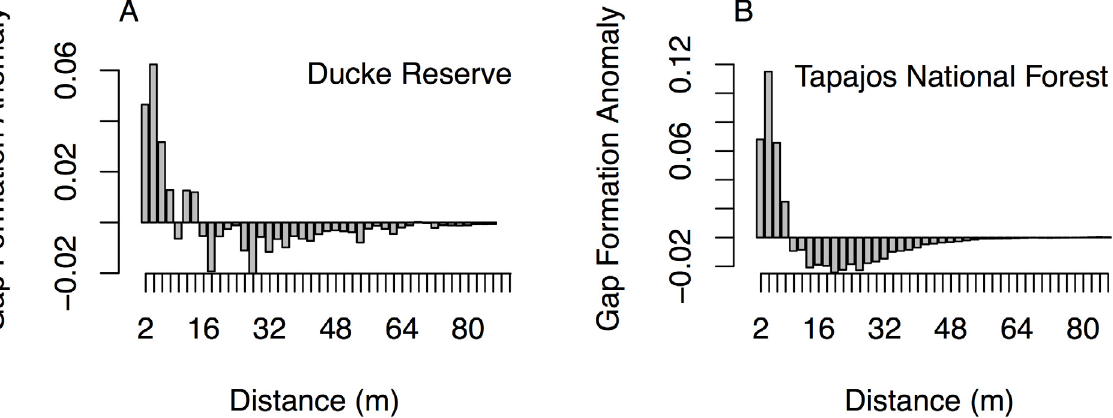
Fig 3. Gap formation anomaly with distance from existing gaps. For each site, the average probability of gap formation between 2008 and 2012 was calculated and subtracted from the probability of gap formation based on distance from existing (2008) gaps. The resulting difference (Gap Formation Anomaly) was plotted against distance for (a) Ducke Reserve and (b) Tapajos National Forest.